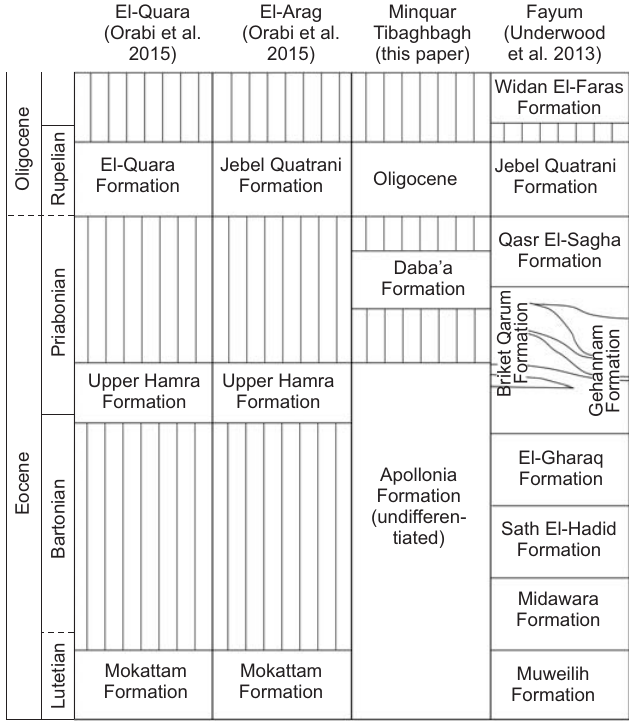
Fig. 3. Comparison between Eocene and Oligocene strata at Minqar Tibagh- bagh, El-Qara, El-Arag, and the Fayum Depression,